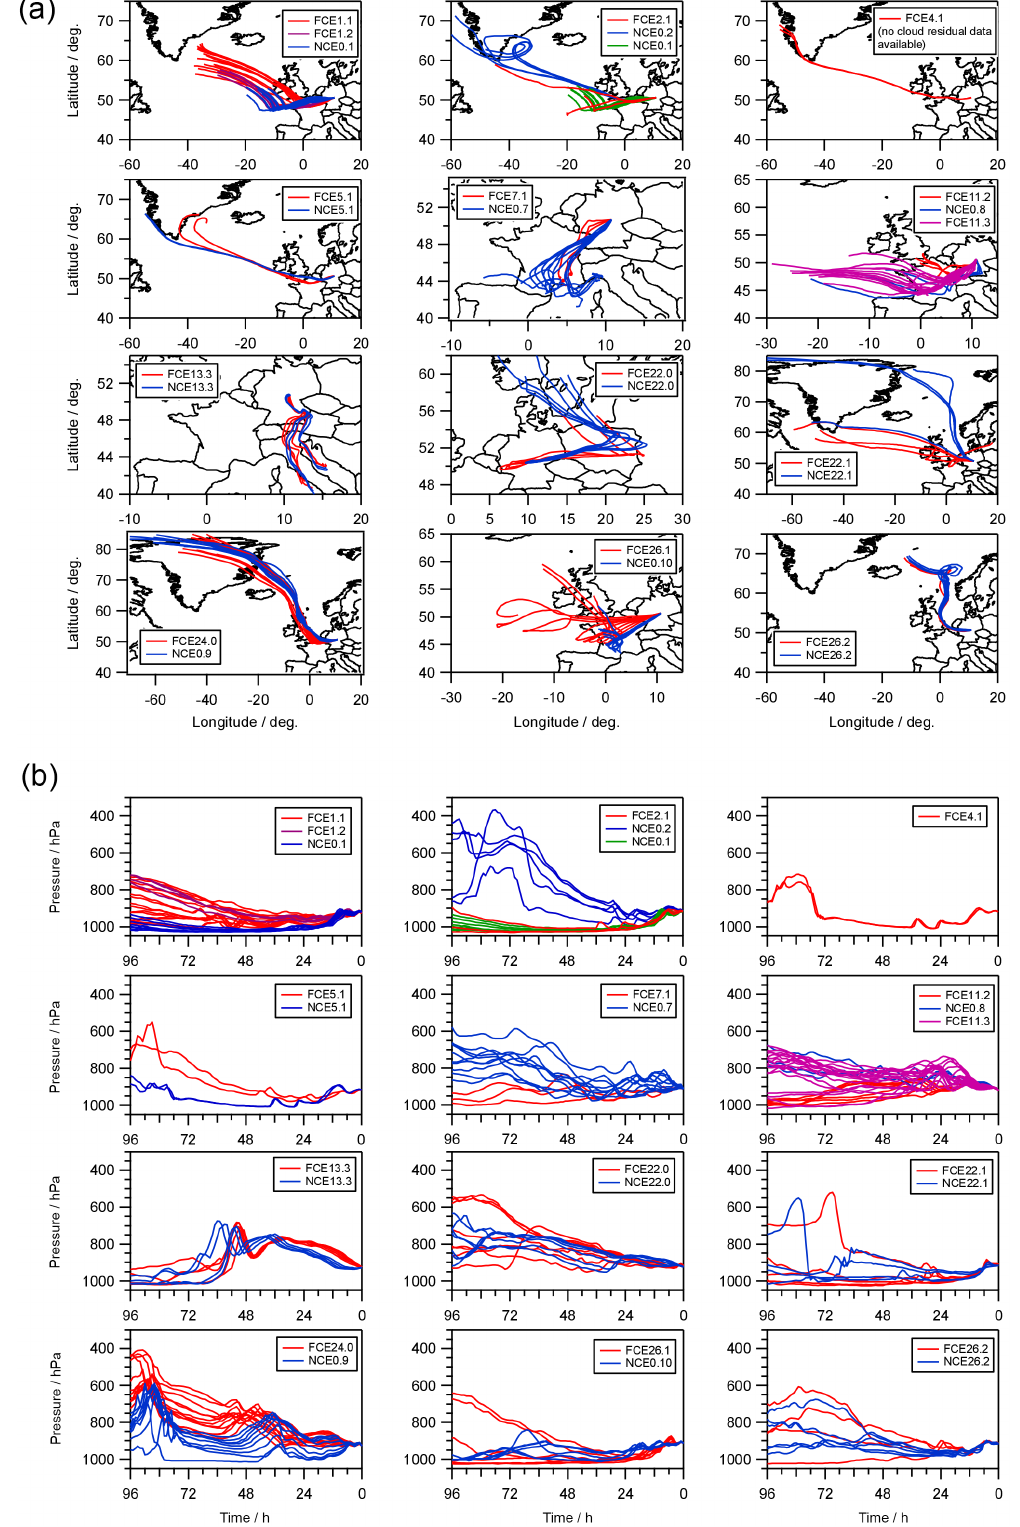
Figure 1. Back trajectories calculated using HYSPLIT (Stein et al., 2015; Rolph, 2016) for all full cloud events (FCEs) and the according cloud-free periods. The trajectories go back 96h in time, the end point is 50.65 ◦ N, 10.77 ◦ E at 500m above model ground level. (a) Trajec- tories as latitude/longitude plots; (b) pressure of the air mass as a function of time. Details of the trajectory calculations are described in the Supplement to Tilgner et al.